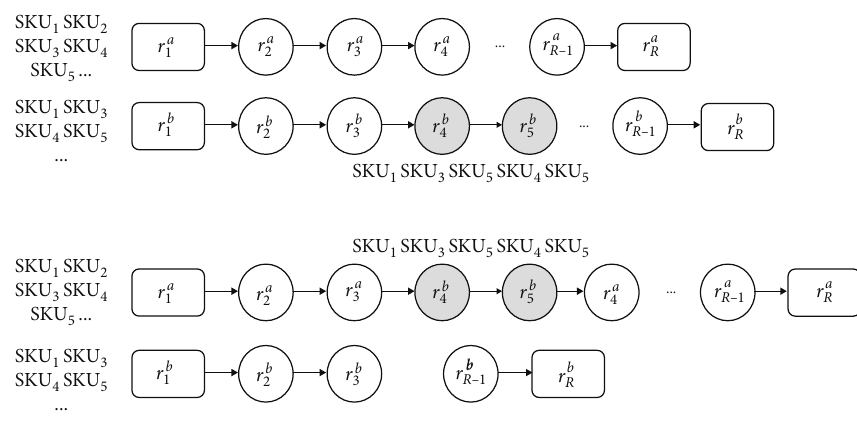
Figure 8: The diversi fi cation